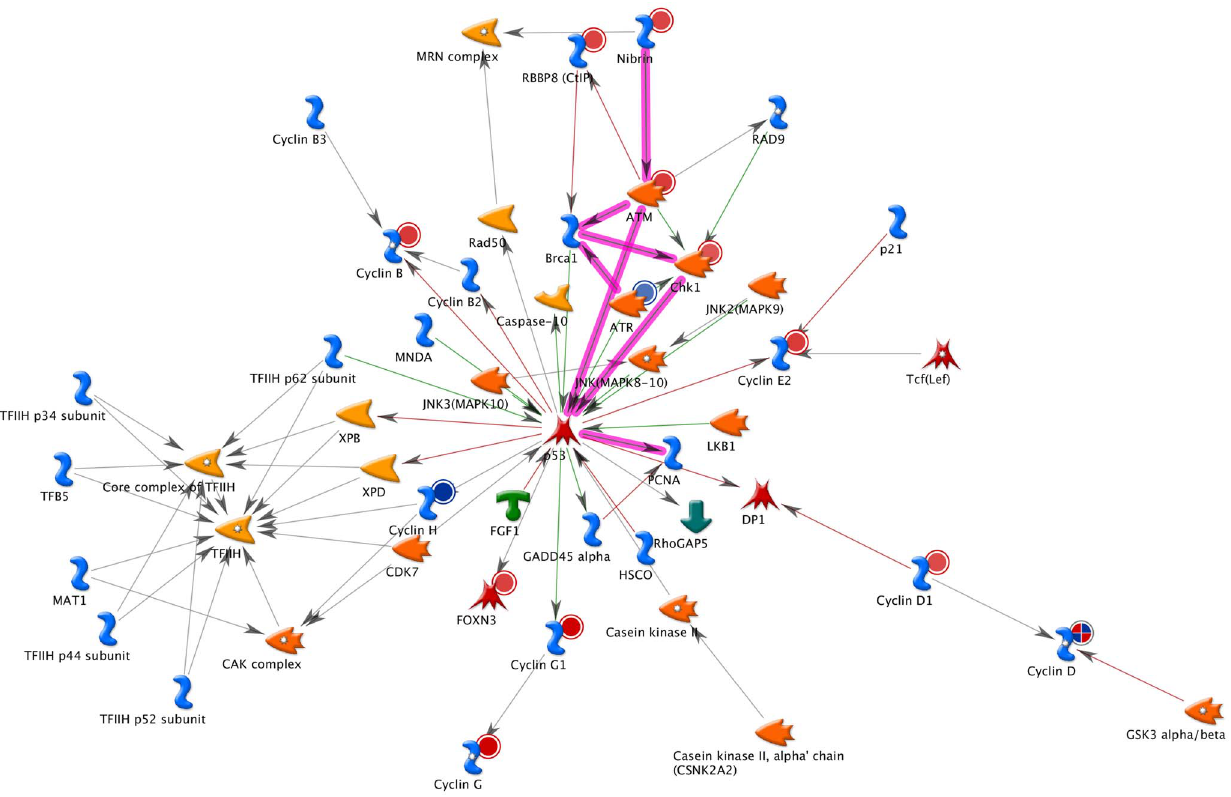
Figure 1. The mitotic cell cycle checkpoint gene network generated by the MetaCore and overlaid with the color coded gene expression changes during dementia. (red – upregulation; blue – downregulation; combination red/blue – differential effect at various stages of dementia). Highlighted is ATM/ATR regulation of G1/S transition pathways. The tumor protein p53 is a hub gene in this network. doi:10.1371/journal.pone.0068361.g001 df = 43, p= 0.004), but not with Braak scores (r = –0.103, df= 43, with increased severity of dementia from questionable (CDR 0.5), p = 0.497) or NP density (r = –0.230, df= 43, p= 0.124). Compar- ison of individuals without dementia (NL =CDR 0), to groups decrease of TIGAR protein expression (Figure 4) in individuals